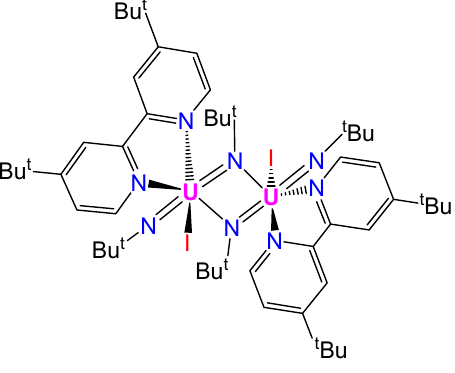
Figure 8. Structure of the U 2 N 2 core [106].